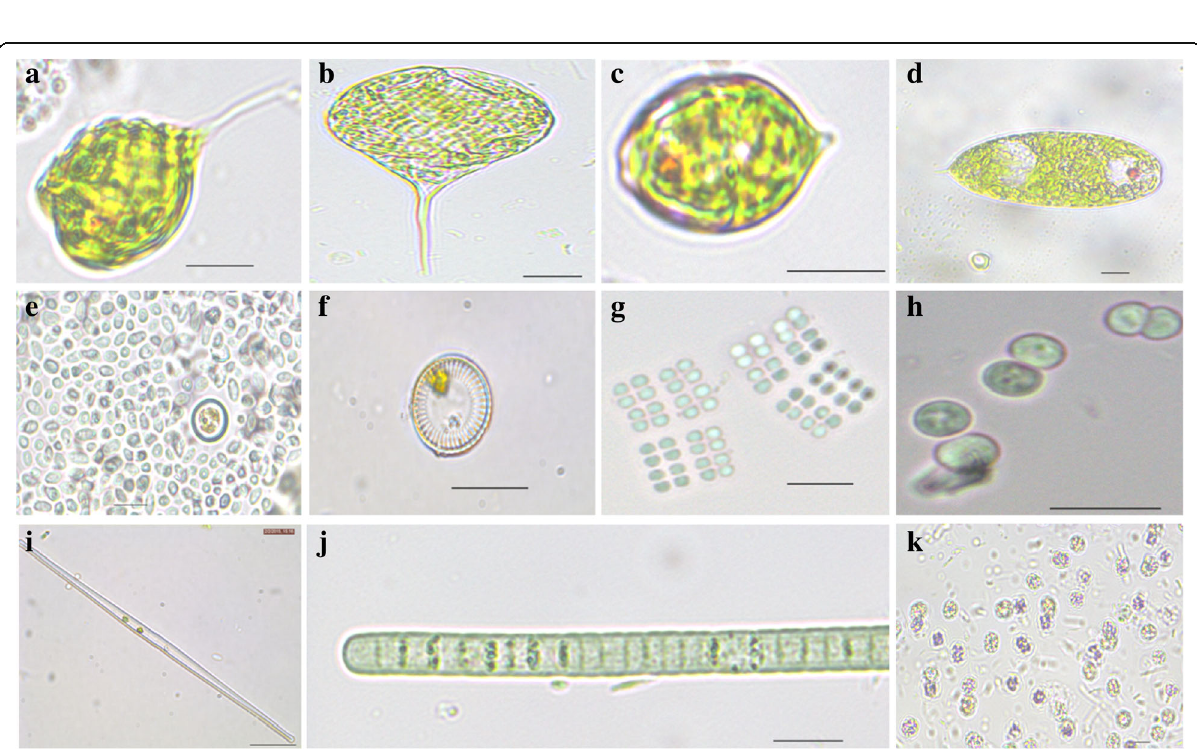
Fig. 3 Photomicrograph of phytoplankton observed during the present study. a . Crucigeniella quadrata, b . Scenedesmus opaliensis, c . Pediastrum duplex, d . Crucigeniella crucifera, e . Tetraedron lobulatum, f . Scenedesmus dimorphus g . Staurastrum iotanum, h . Crucigenia fenestrata, i . Tetraedron minimum, j . Coelastrum microporum, k . Coelastrum cambricum, l . Scenedesmus bijugatus. Scale bar, 10 μ m